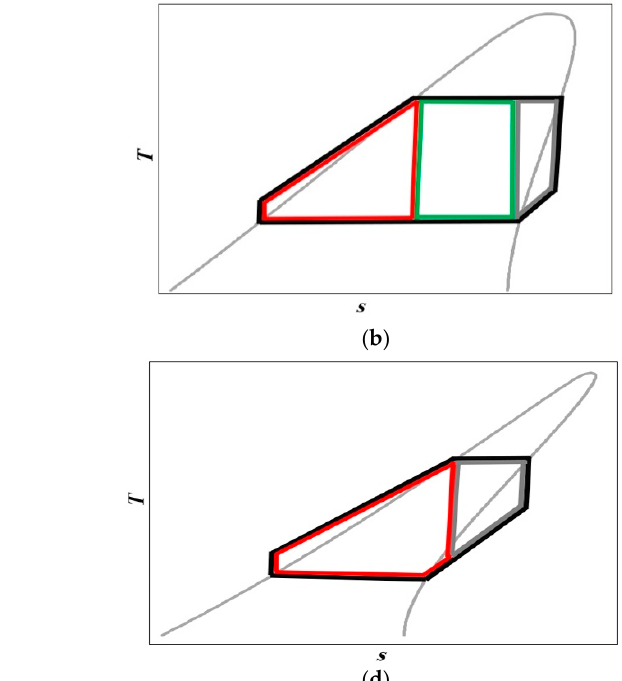
Figure 8. Schematic temperature-efficiency ( a ) and its inverse, efficiency-temperature ( b ) curves of an ORC-like and TFC-like system, explaining the necessity of the maximum. Further explanation can be found in the text.